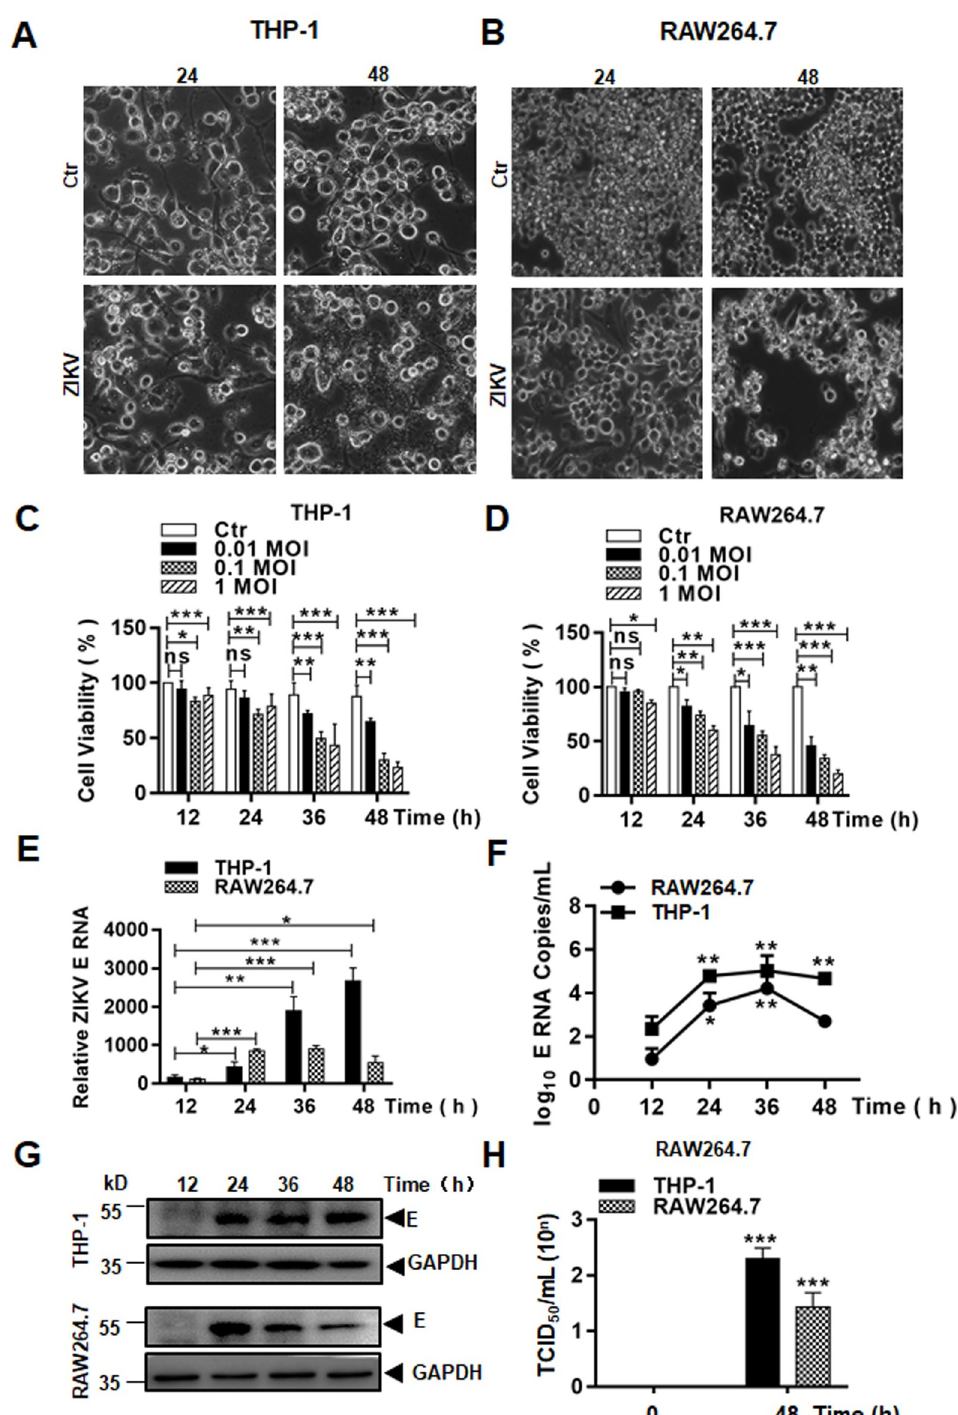
Fig 1. Viral replication and cell death caused in ZIKV-infected macrophages. Human THP-1 ( A ) and mouse RAW264.7 ( B ) cells were infected with ZIKV at 1 MOI and shown cytopathic effect (CPE) at 24 and 48 hrs p.i. (Magnification x40). Cell viability was assessed at various time points p.i. in THP-1 ( C ) and RAW264.7 ( D ) cells infected with ZIKV at various MOIs by an MTT assay. Total RNA was prepared for realtime RT-PCR to measure copy numbers of ZIKV E RNA in infected THP-1 and RAW264.7 cells. A SYBR Green approach for fold change ( E ) and a TaqMan approach ( F ) for viral RNA copy numbers were performed. ( G ) ZIKV E protein expression was detected in cell lysates